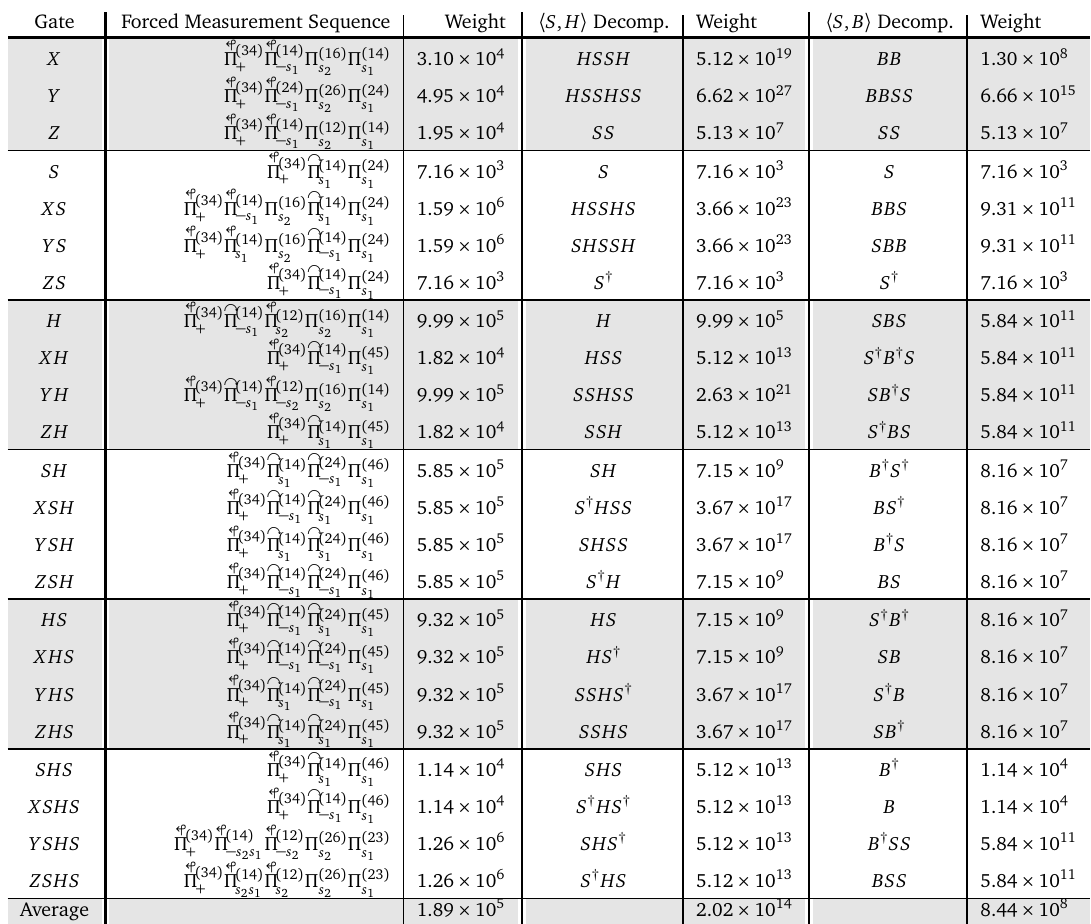
Table 21: Minimal difficulty weight measurement sequences for each single-qubit Clifford gate when using forced-measurement methods. For comparison, we also present the corresponding realization of the gates formed by using the generating gate sets 〈 S , H 〉 and 〈 S , B 〉 .